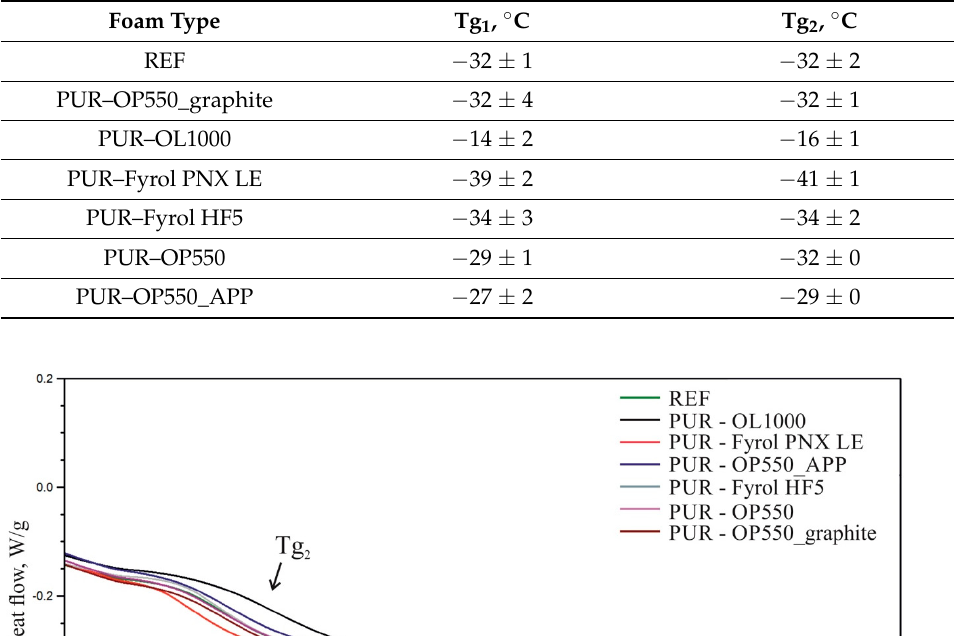
Figure 5. Summary of thermograms obtained during the first heating of the samples. Table 6. Glass-transition temperatures of the foams.